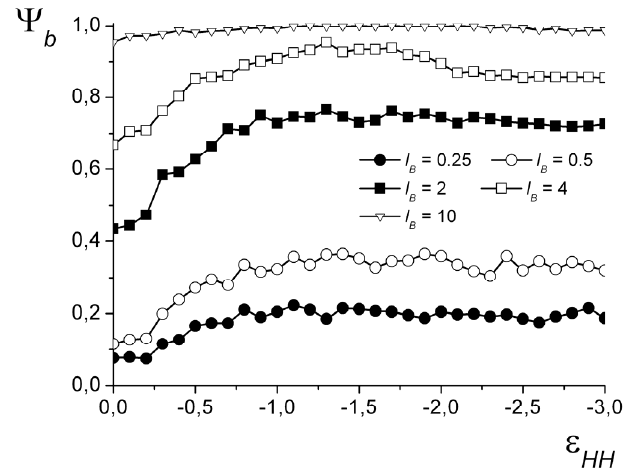
Figure 8. The fraction of groups forming ion pairs depending on HH ε at different l B . N = 1024.